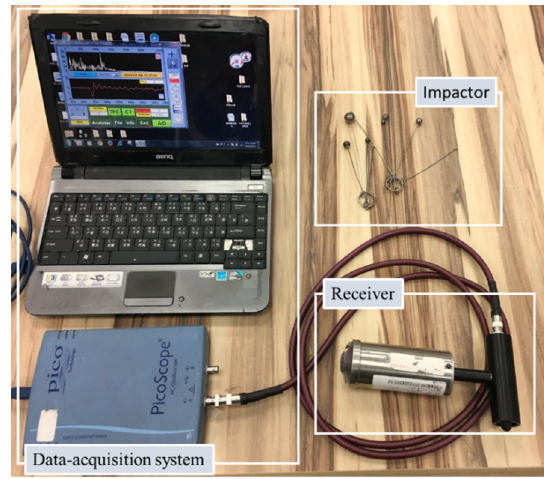
Figure 6. Instruments for performing the IE test.